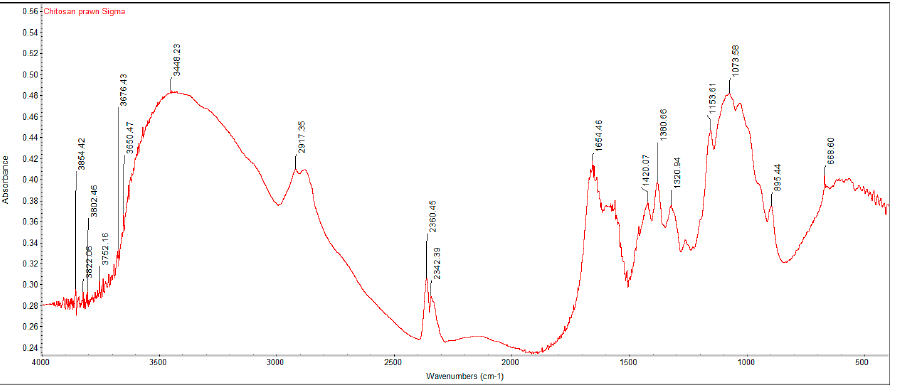
Figure 5. FTIR spectra of commercial chitosan. Table 2. FTIR bands (cm − 1 ) for commercial chitin and chitosan versus extracted crustacean chitin from